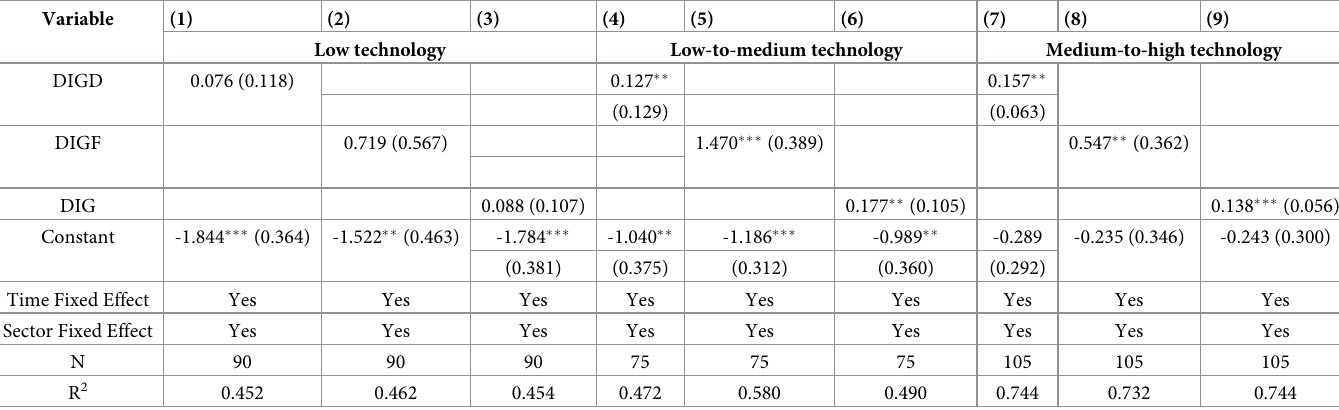
Table 7. Technology level heterogeneity